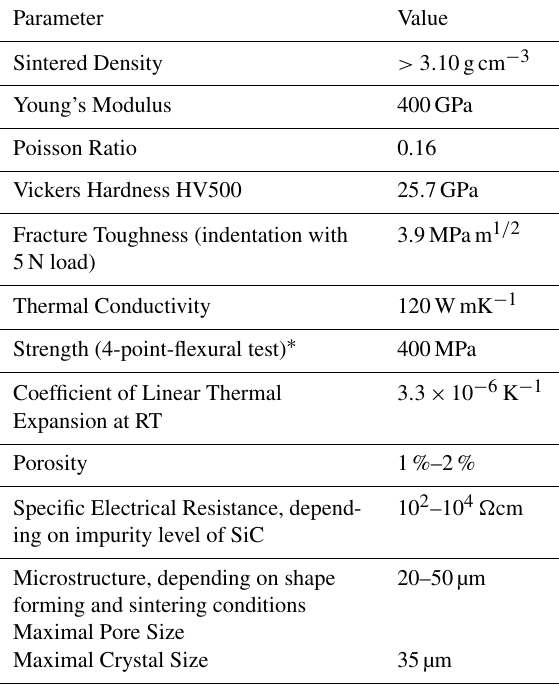
Table 2. Material parameter of SSiC (SiCeram GmbH,